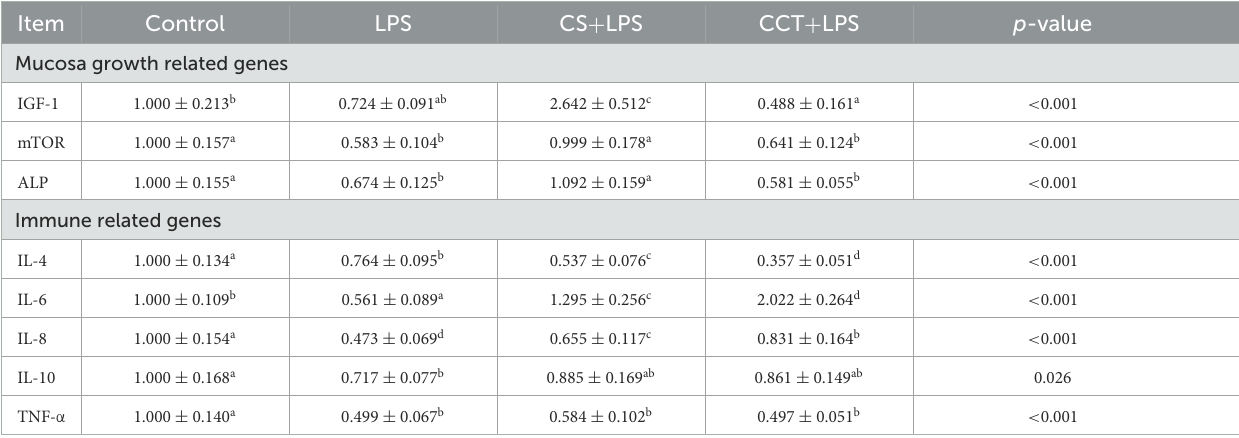
TABLE 6 Effects of CCT supplementation on the mRNA levels of mucosal growth-related genes, immune-related genes and mucosal energy metabolism-related genes in the jejunum in piglets after LPS challenge. Item